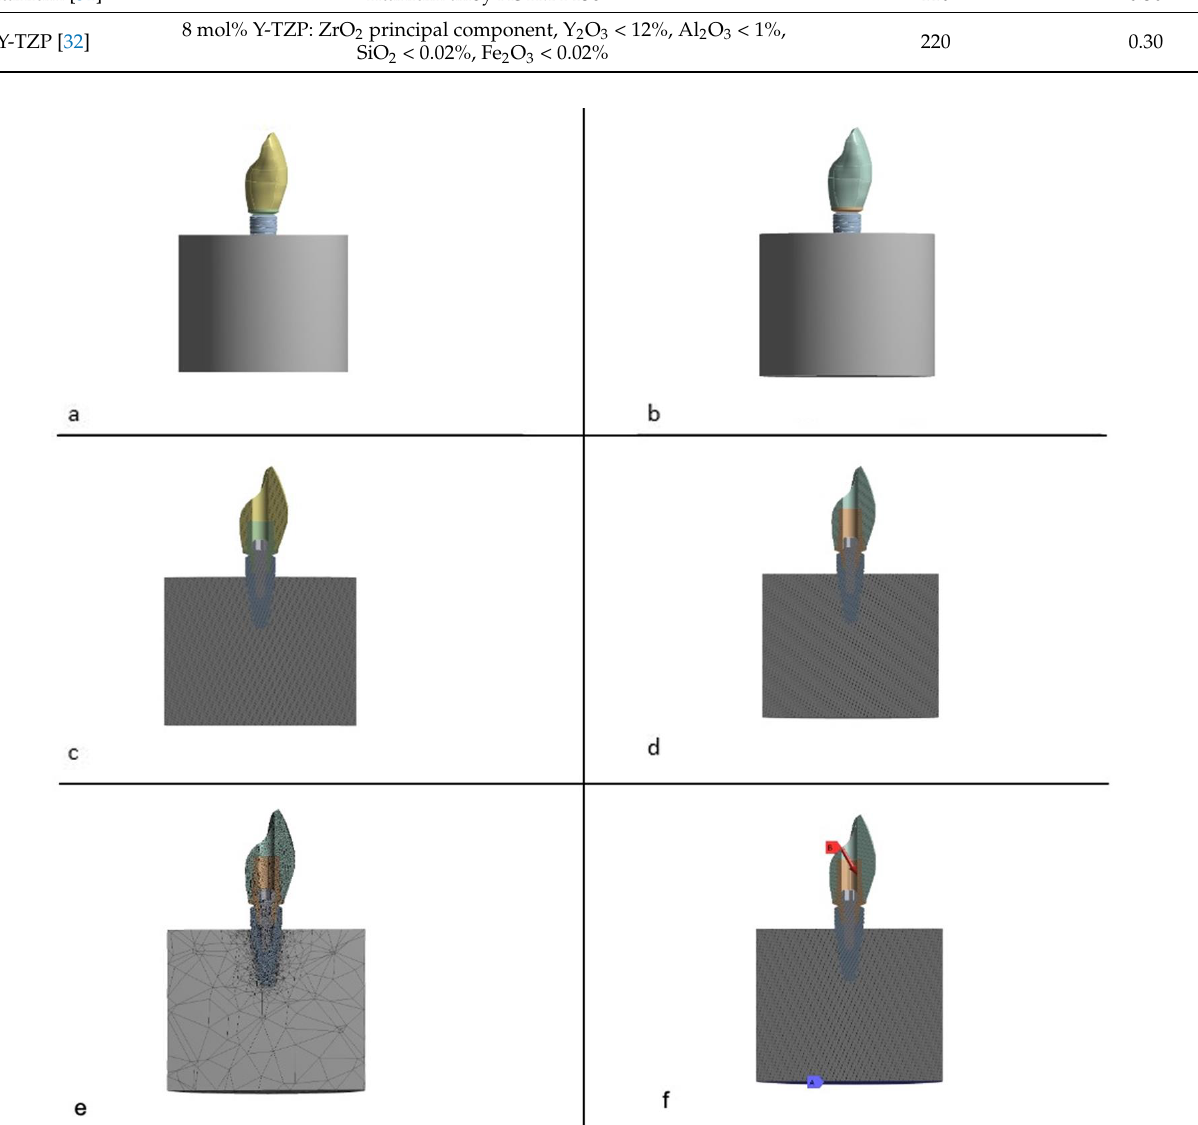
Figure 7. Assembly of sets consisting of implant, abutment, screw, and monolithic crown. Three- dimensional assembly of the short abutment ( a ), and long abutment ( b ); section view of the assembly of the short model ( c ); and section view of the assembly of the long model ( d ). Initial mesh division ( e ), and load application axis ( f ).